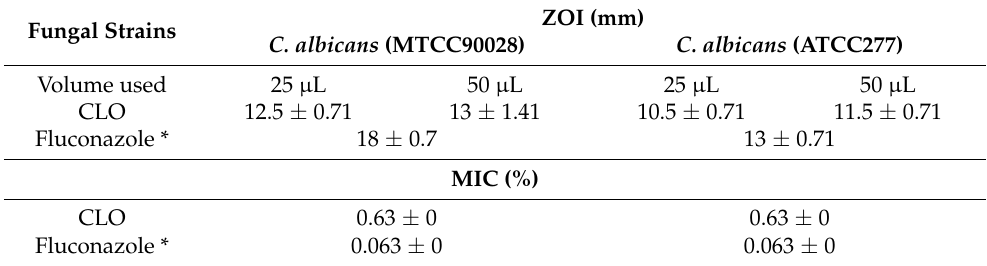
Table 2. Antifungal activity exhibited by CLO using agar well diffusion and the broth dilu- tion